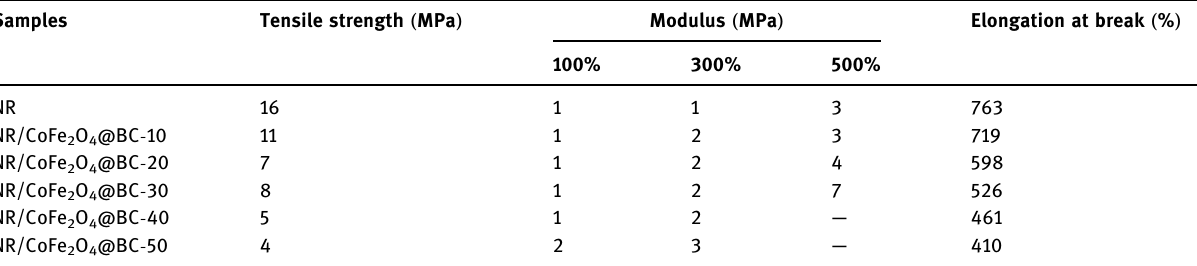
Table 1: Mechanical property of NR and its composites with CoFe 2 O 4 @BC